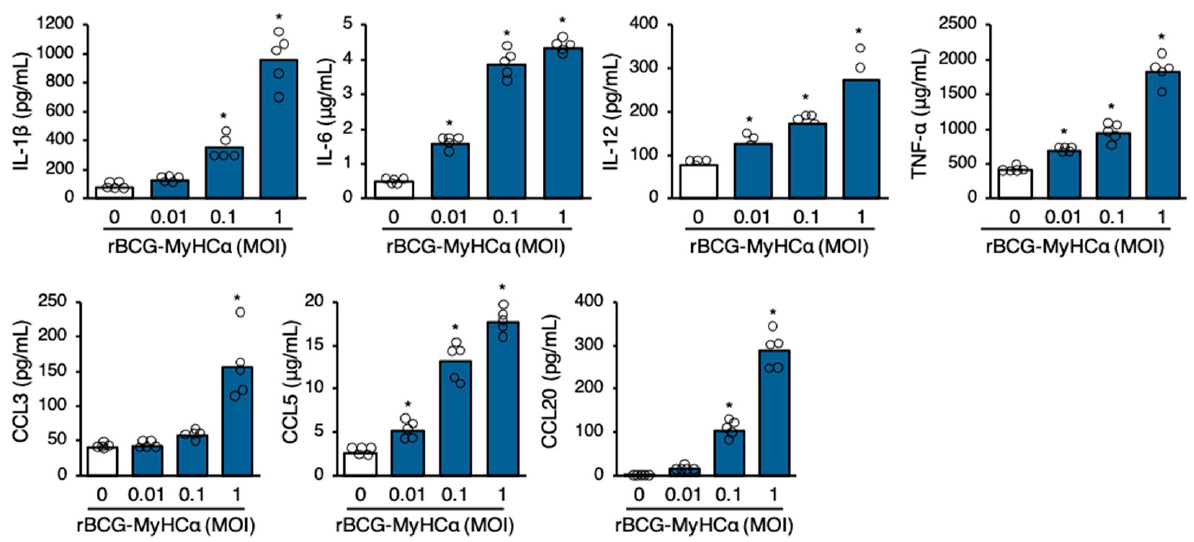
Figure 7. rBCG-MyHC α promoted cytokine and chemokine production in DCs. BMDCs were infected with rBCG-MyHC α at the indicated MOIs for 72 h. Cytokine and chemokine concentrations in the culture supernatant were assessed by ELISA. The values are expressed as means of pentuiplicate wells. * p < 0.05 vs. MOI 0 by one-way ANOVA with Tukey’s post hoc test.